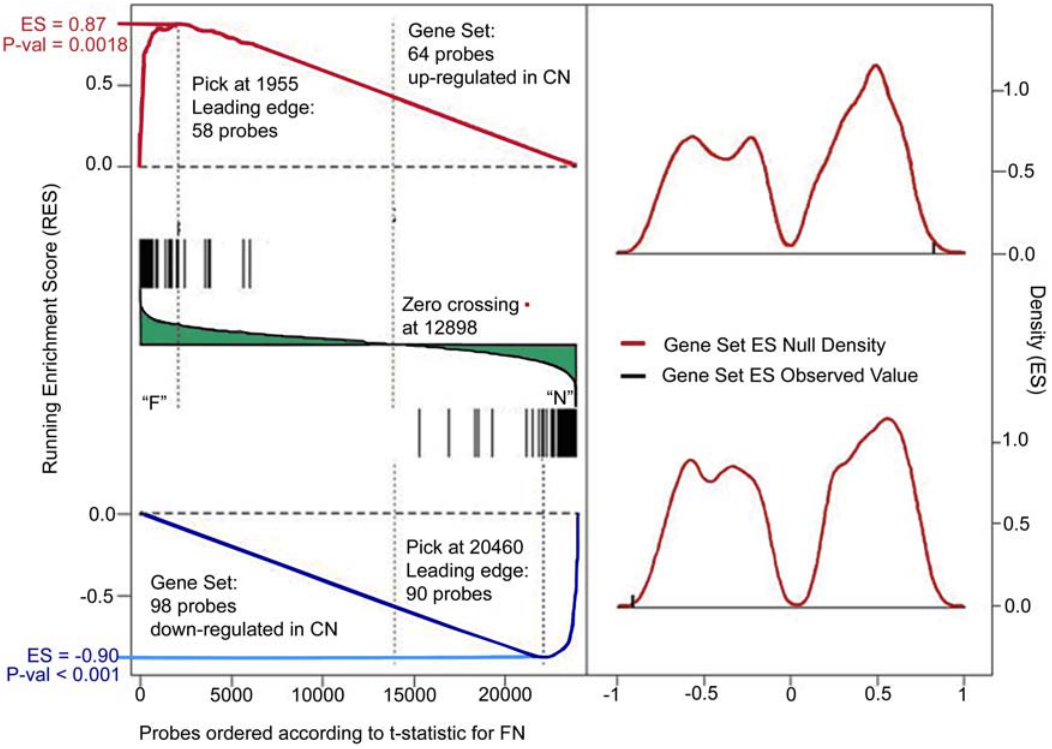
Figure 1. Comparison of gene expression differentiating current from never smokers (C/N) and gene expression differentiating former from never smokers (F/N) in early stage tumor tissue (T) using Gene Set Enrichment Analysis (GSEA). Left : Running Enrichment Score (y axis) is calculated by walking down the entire list of probes from Affymetrix HG-U133A chip (numbered from 1 to 22,283 in the x axis) ordered by the ANOVA coefficients divided by the standard error values from the Former/Never (F/N) smoking comparison. This running-sum statistic increases when a given probe is in the Current/Never (C/N) Gene Set of interest and decreases when the probe is not in the C/N Gene Set, with the magnitude of increment depending on the strength of the correlation between the probe and the F/N comparison. The Enrichment Score (ES) is the maximum deviation of the Running Enrichment Score from zero encountered in the random walk and reflects the degree to which the Gene Set is overrepresented at the extremes (top or bottom) of the entire ranked probe list. We report results for two different C/N Gene Sets: on the top, the 64 up-regulated probes, with ES=0.87 and, on the bottom, the 98 down-regulated probes, with ES= 2 0.90. A leading edge subset of the Gene Set is defined as those probes in the Gene Set that appear in the probes ranked list at, or before, the point where the running sum reaches its maximum deviation from zero. The leading edge for the Gene Set of the C/N up-regulated probes contains 58 probes over 64 and the leading edge for the Gene Set of down-regulated probes contains 90 over 98 probes. This confirms that among the 64 up-regulated probes from the C/N comparison, 58 are also found in the F/N comparison; and among the 98 down-regulated probes from the C/N comparison, 90 are also found in the F/N comparison. Right : distributions of ES values created using a permutation procedure for (top) the Gene Set of up-regulated probes in C/N and (bottom) the Gene Set of down-regulated probes in C/N. These distributions are used to calculate the statistical significance (nominal p-value) of the observed ES values (p-value , 0.002 in both